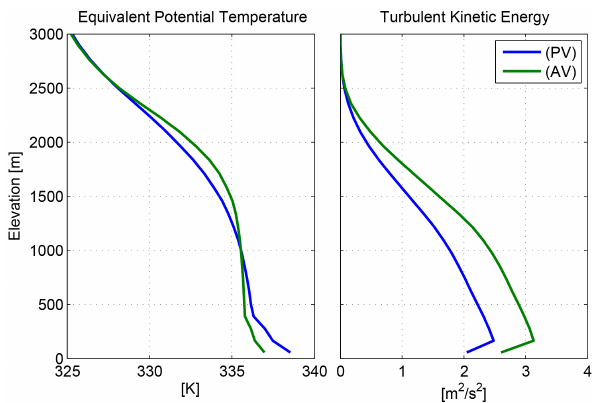
Figure 12. Mean profiles of Equivalent Potential Temperature and Turbulent Kinetic Energy at 15Z within the bounded domain at Pará, September